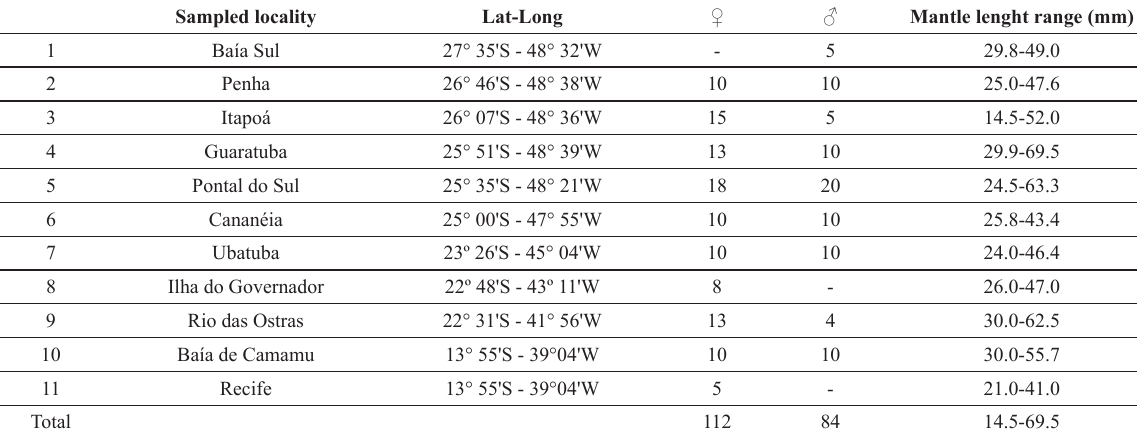
Positions, latitude-longitude points (Lat-Long) and number of females and males of Lolliguncula brevis collected per sample for morphological and morphometric analysis. The numbers of locations sampled correspond to the points shown in Figure